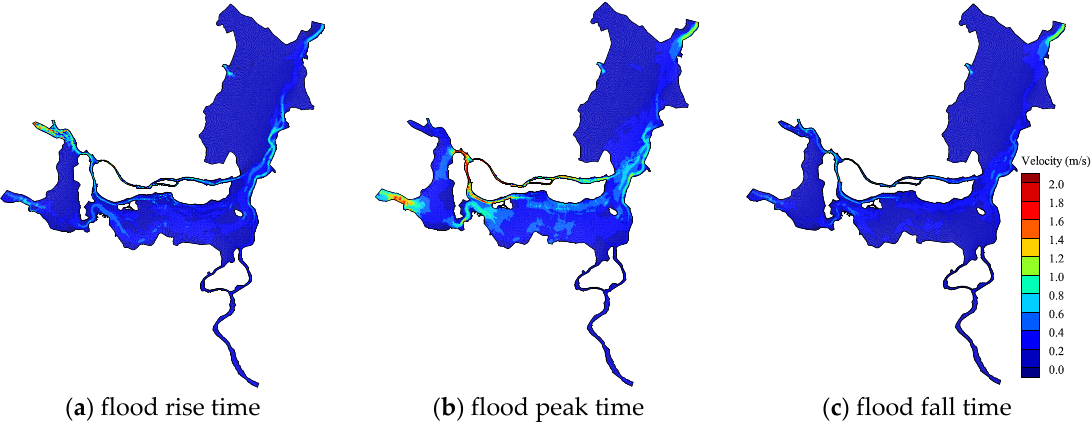
Figure 5. The flow velocity contour without the construction of the central lake reservoir (unit: m/s)